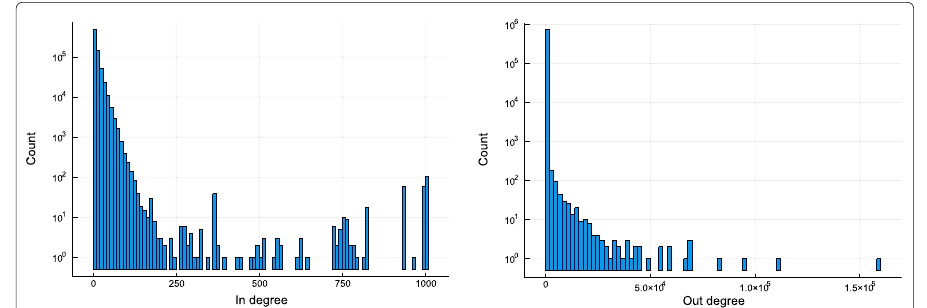
Fig. 4 npm degree distributions. In and out degree distributions for the npm package